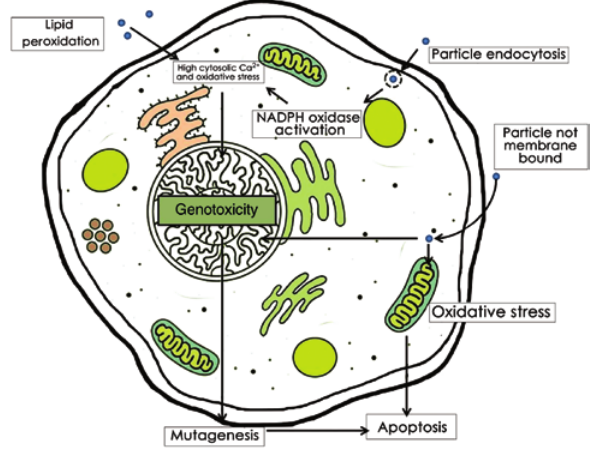
Figure 3: Various routes of particle entry and stress generation.